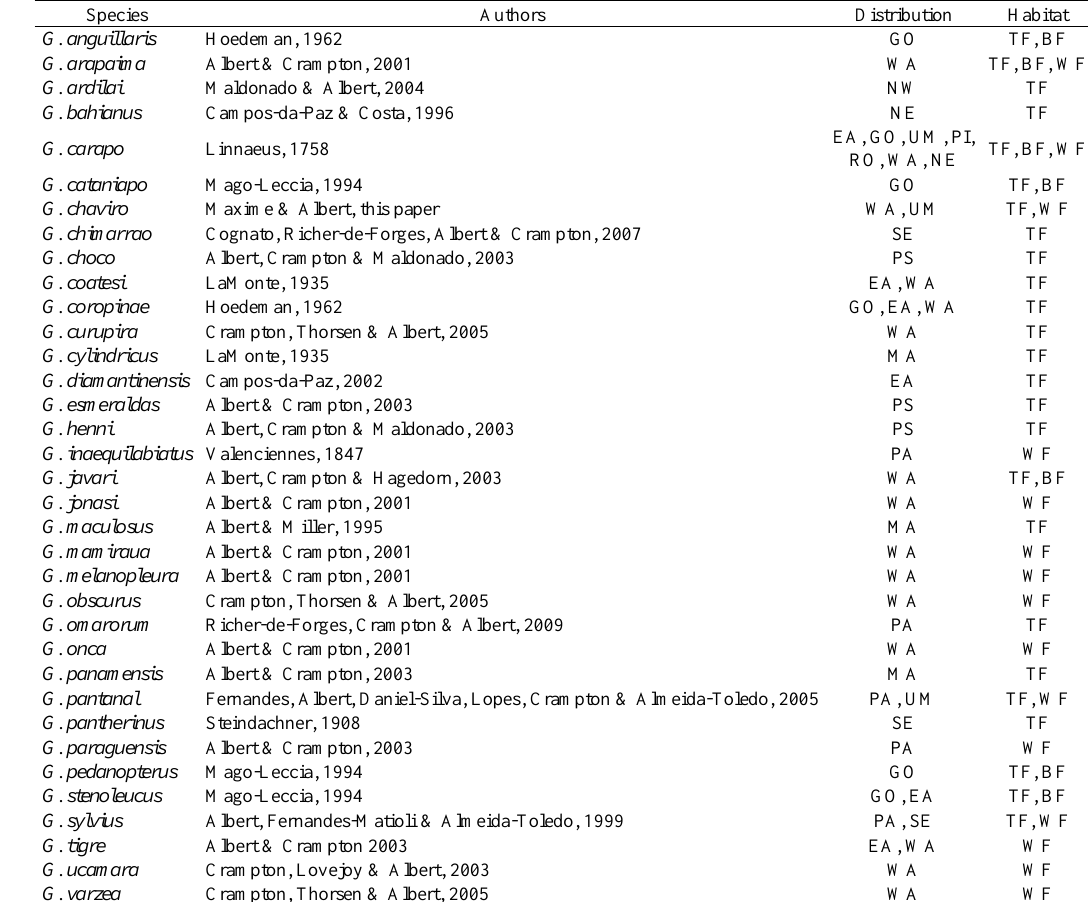
Table 1. Valid species of Gymnotus with geographic range by drainage basin and habitat. Species arranged alphabetically. Distributional regions: EA, Eastern Amazon (including lower Negro, Trombetas, Tapajós, Tocantins); GO, Guianas-Orinoco (including Trinidad, upper Negro above São Gabriel); MA, Middle America; UM, Upper Madeira (including Mamoré, Guaporé, Beni, Madre de Dios); NE, Northeastern Brazil (from São Francisco to Jequitinhonha); NW, Northwestern South America (including Magdalena and Maracaibo); PA, Paraguay-Paraná and Uruguay; PI, Piauí (including Itapicuru and Parnaíba); PS, Pacific slope Colombia and Ecuador; RO, Roraima (including Branco); SE, Southeast coast Brazil; WA, Western Amazon (including affluents west of mouth of Purús). Habitat = TF, terra firme; WF, whitewater floodplain (várzea); BF, blackwater